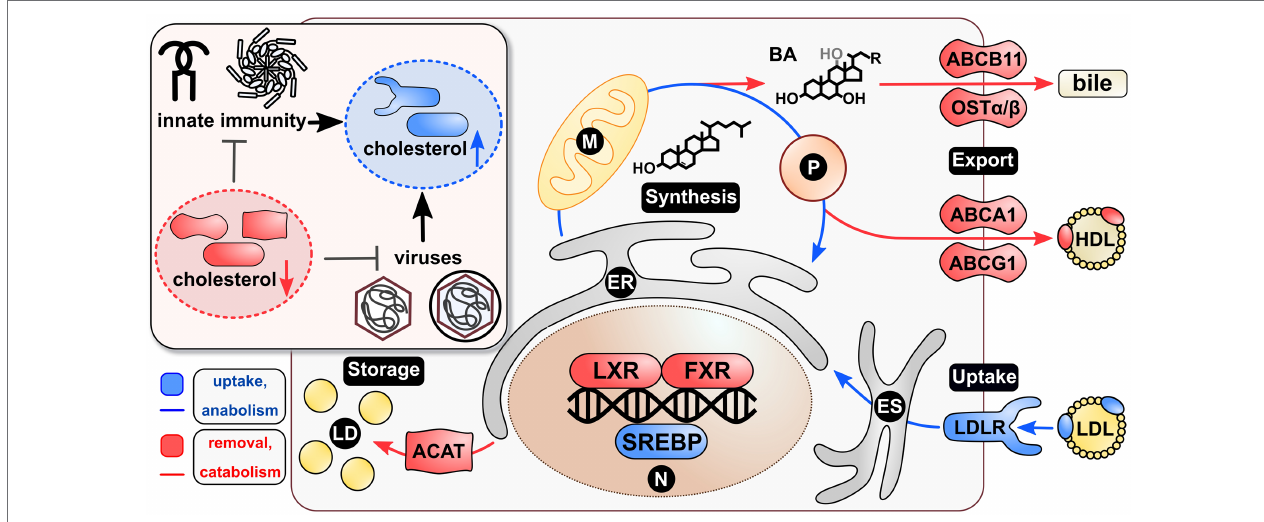
FIGURE 1 | Viruses and innate immunity shift the cholesterol homeostasis to the side of anabolism and uptake. Maintenance of the cellular cholesterol homeostasis is transcriptionally controlled via SREBPs and LXR/FXR acting as transcription factors. The first induce uptake and anabolism, whereas the latter induce removal and catabolism of cholesterol. Specifically, SREBPs induce the expression of LDLR leading to cholesterol uptake via LDL. This is then shuttled via the ES to the ER to be available in the cell. Further, they induce ER-, P-, and M-mediated de novo synthesis of the lipid. Once excess cholesterol is present in a cell, LXR induces direct cholesterol exporters, such as ABCA1/G1 leading to HDL synthesis. Secondly, LXR primes P- and M-mediated cholesterol derivatization via BA, which are exported by FXR-induced ABCB11 and OST α / β . A third way of removing cholesterol from a cell is the ACAT-dependent storage of cholesterol esters in LDs. Interestingly, both viruses and innate immunity seem to be inhibited by withdrawal of cellular cholesterol. Similarly, both seem to induce mechanisms resulting in elevated cellular cholesterol, thus leading to a strong intertwinement with respect to the requirement of the lipid. Blue coloring = cholesterol uptake or anabolism; red coloring = cholesterol removal or catabolism. BA, bile acids; ER, endoplasmic reticulum; ES, endosomal system; LD, lipid droplets; M, mitochondrion; P, peroxisome; N,